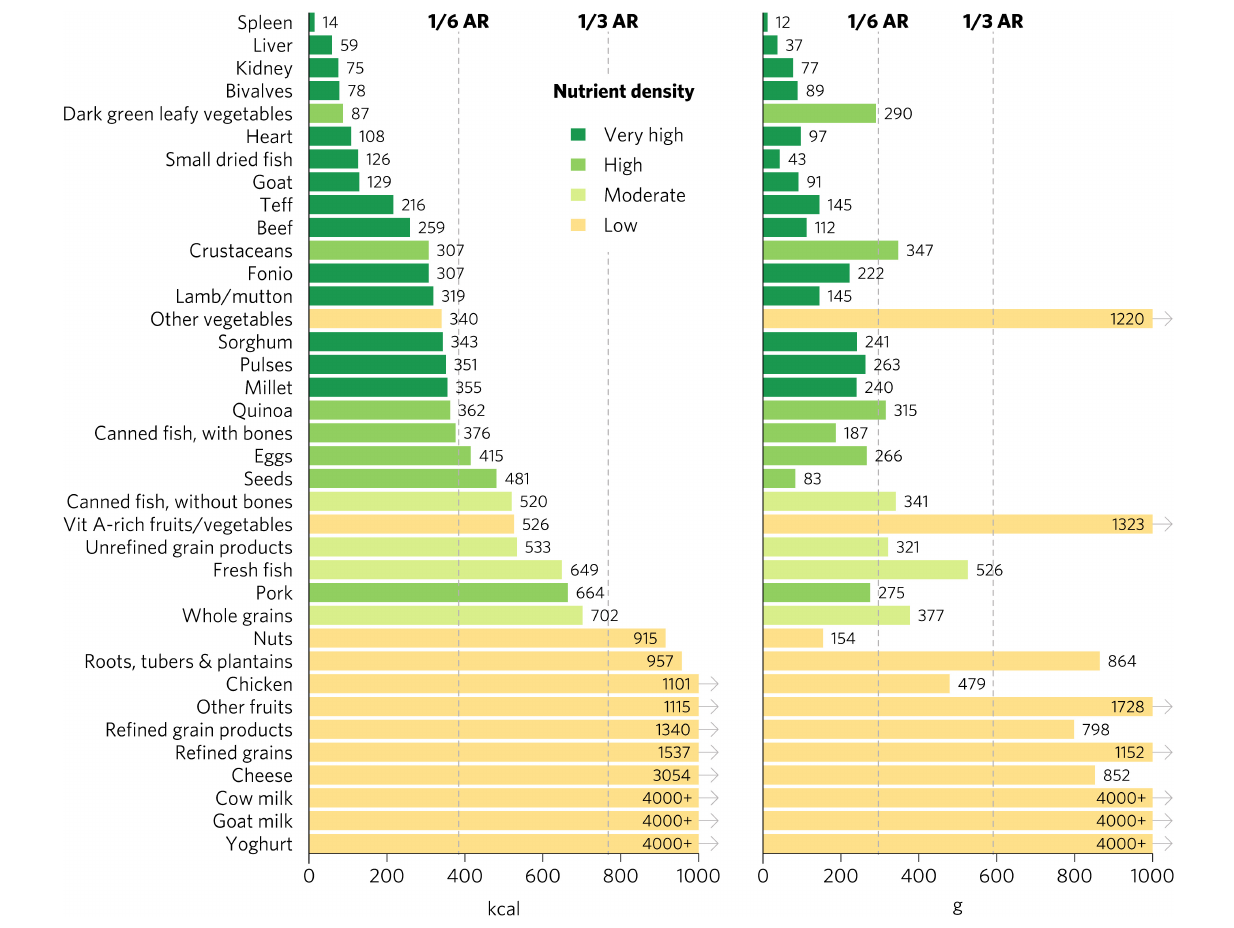
FIGURE 6 | Calories and grams needed to provide one-third of recommended iron intakes for adults ≥ 25. Hypothetical average requirements for mass are based on an energy density of 1.3 kcal/g. AR, average requirement; Vit,